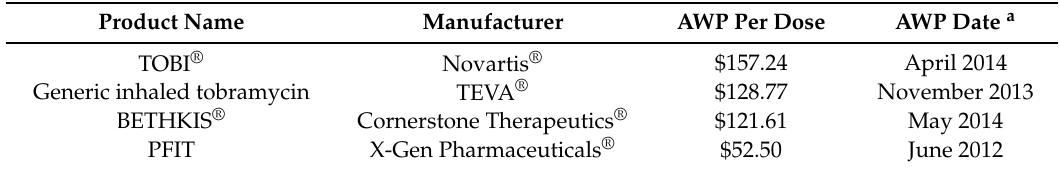
Table 2. Cost-comparison of inhaled tobramycin products [22].